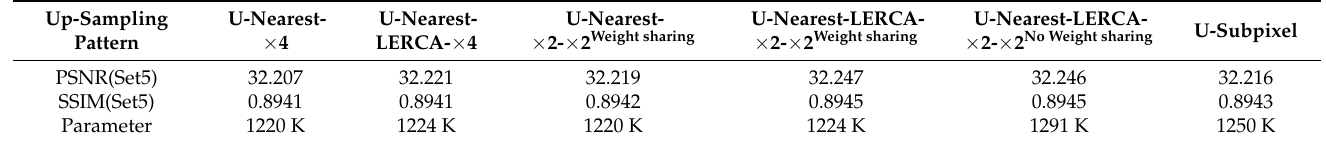
Table 3. Effectiveness of attention mechanism and distributed processing in the reconstruction